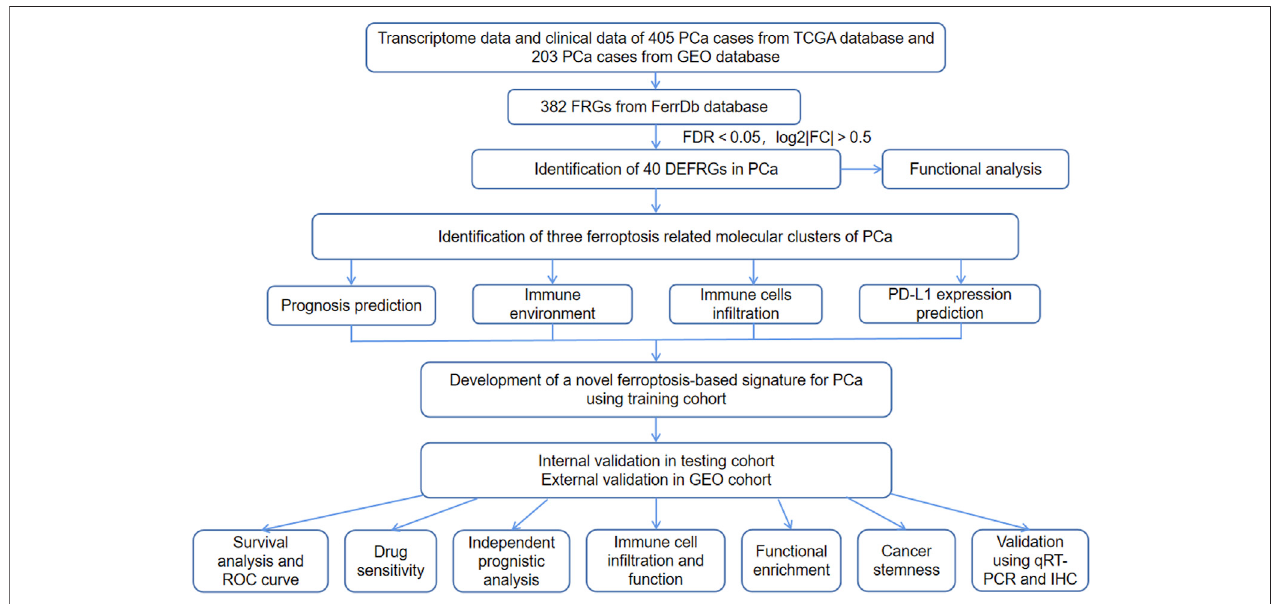
FIGURE 1 | The fl ow chart of this study.